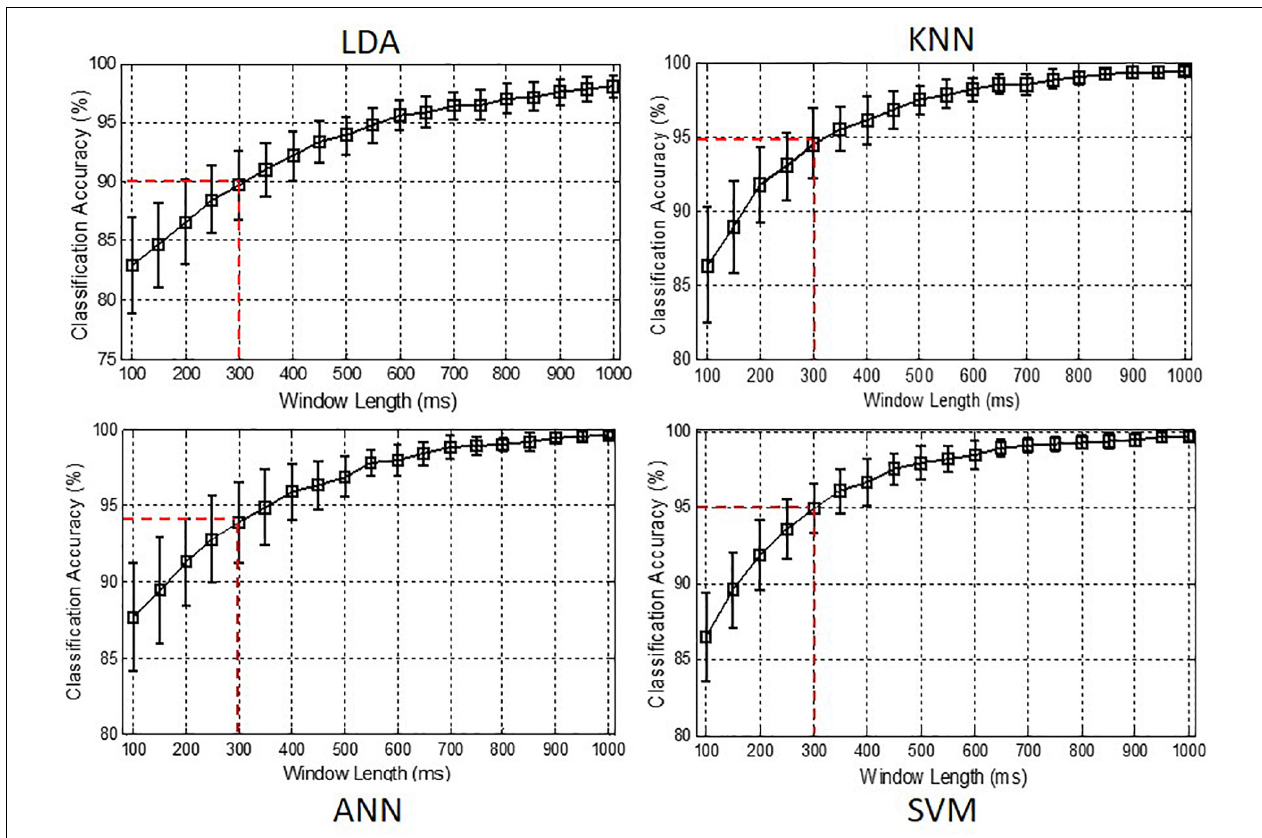
FIGURE 7 | Classification accuracies achieved by using different window lengths for classifiers of LDA, KNN, ANN, and SVM, respectively.